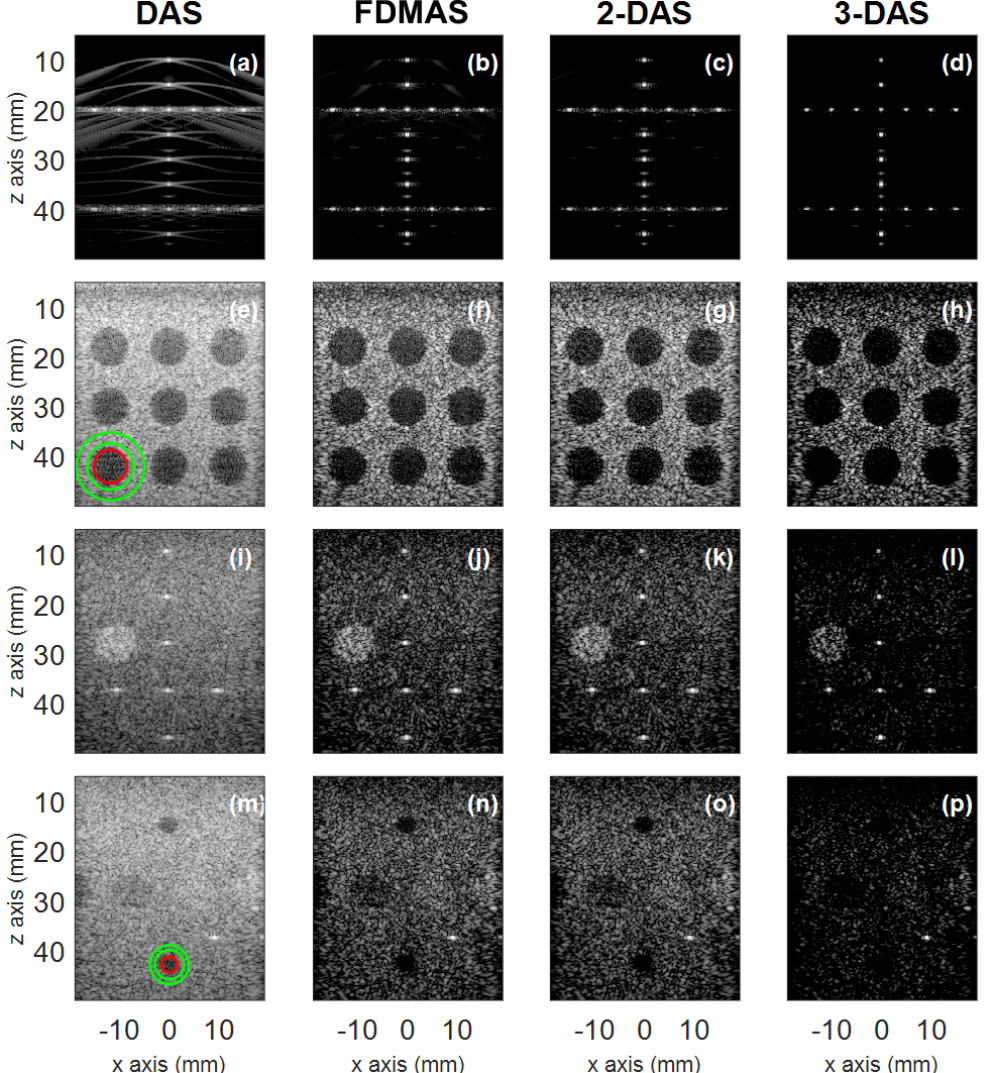
Figure 2. B-mode images obtained with single plane wave imaging for the four phantoms and the four beamformers compared: DAS ( a , e , i , m ), FDMAS ( b , f , j , n ), 2-DAS ( c , g , k , o ), and 3-DAS ( d , h , l , p ). ( a – d ) the numerical phantom used for the resolution; ( e – h ) the numerical phantom used for the contrast; ( i – l ) the experimental phantom used for the resolution; and ( m – p ) the experimental phantom used for the contrast. All of the images are displayed with a 60-dB dynamic range. An example of the boundaries chosen for the contrast metrics is given for simulation ( e ) and experiment ( m ), with the inside of the cyst in red, and the outside of the speckle ring in